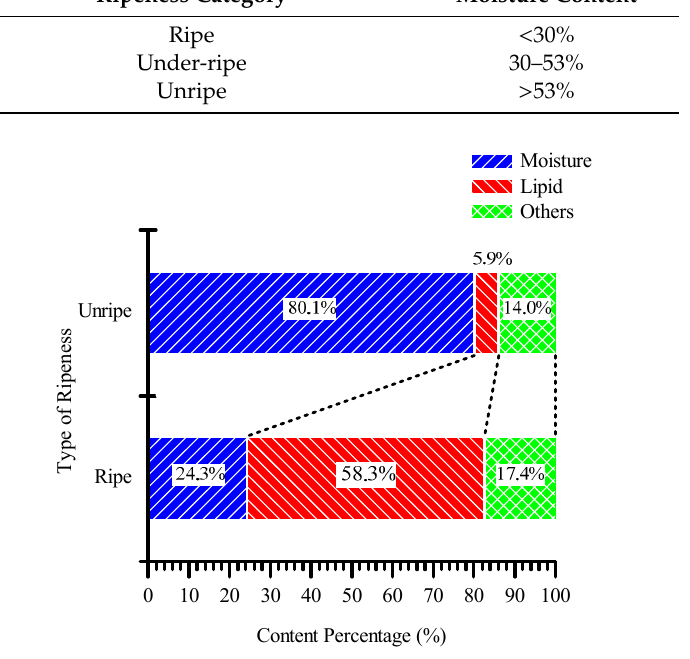
Figure 1. The composition of unripe and ripe fruit [11].